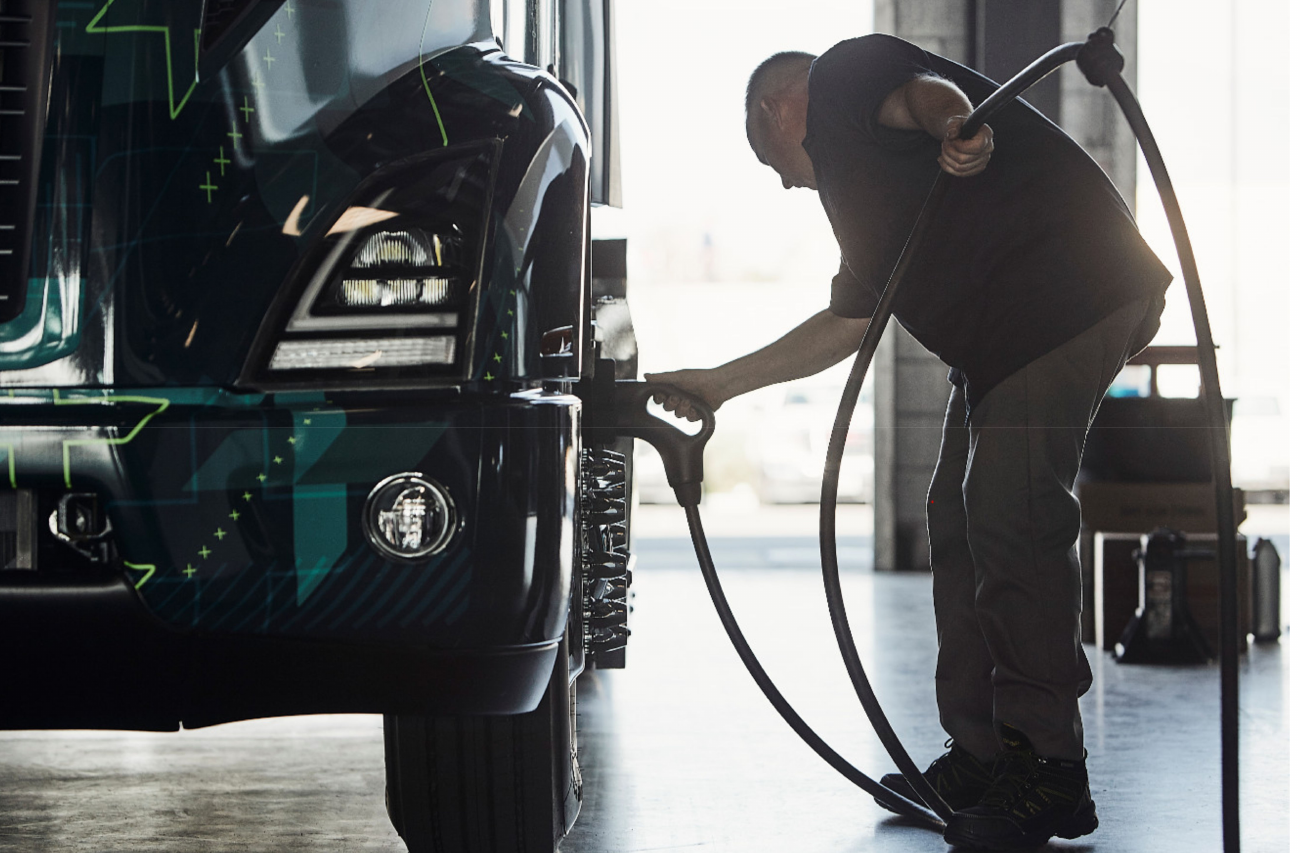
Figure 4. A Volvo VNR Electric is being plugged in to charge